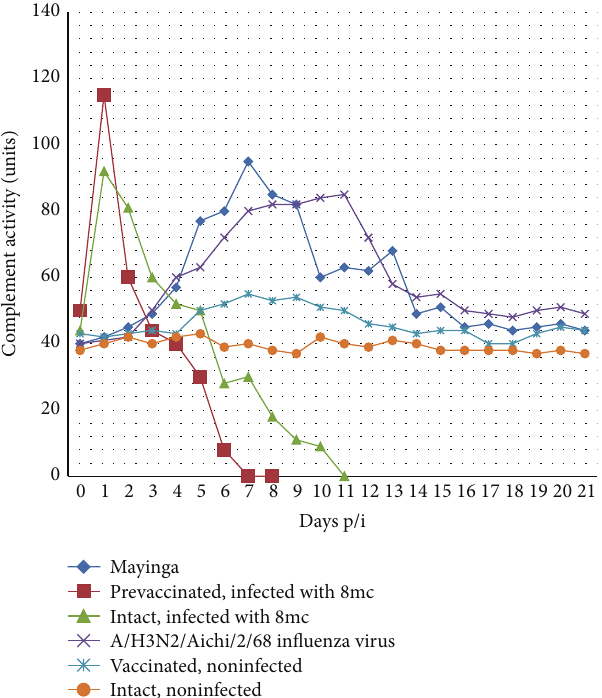
Figure 4: Complement activity in the intact and prevaccinated guinea pigs infected with lethal GPA-EBOV-8mc strain or nonlethal wild-type EBOV Mayinga strain. Animals infected with nonlethal influenza virus A/Aichi/2/68 (H3N2) strain, intact animals, and guinea pigs vaccinated with inactivated nonlethal Mayinga strain EBOV while not infected were used as different controls of com- plement activity. Slow lagging dynamics of complement activity in guinea pigs infected with nonlethal Mayinga strain EBOV is contrasting to the rapid onset/drop peak of complement activity in the intact and prevaccinated animals infected with a lethal 8mc strain